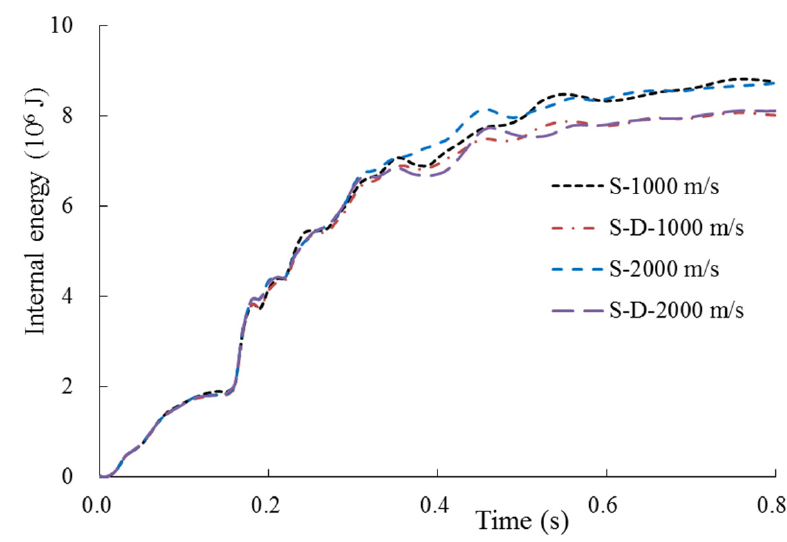
Figure 13. Contours of the maximum impact displacement and concrete peeling off area of full SC containment. ( a ) Vs = 1000 m/s. ( b ) Vs = 2000 m/s.